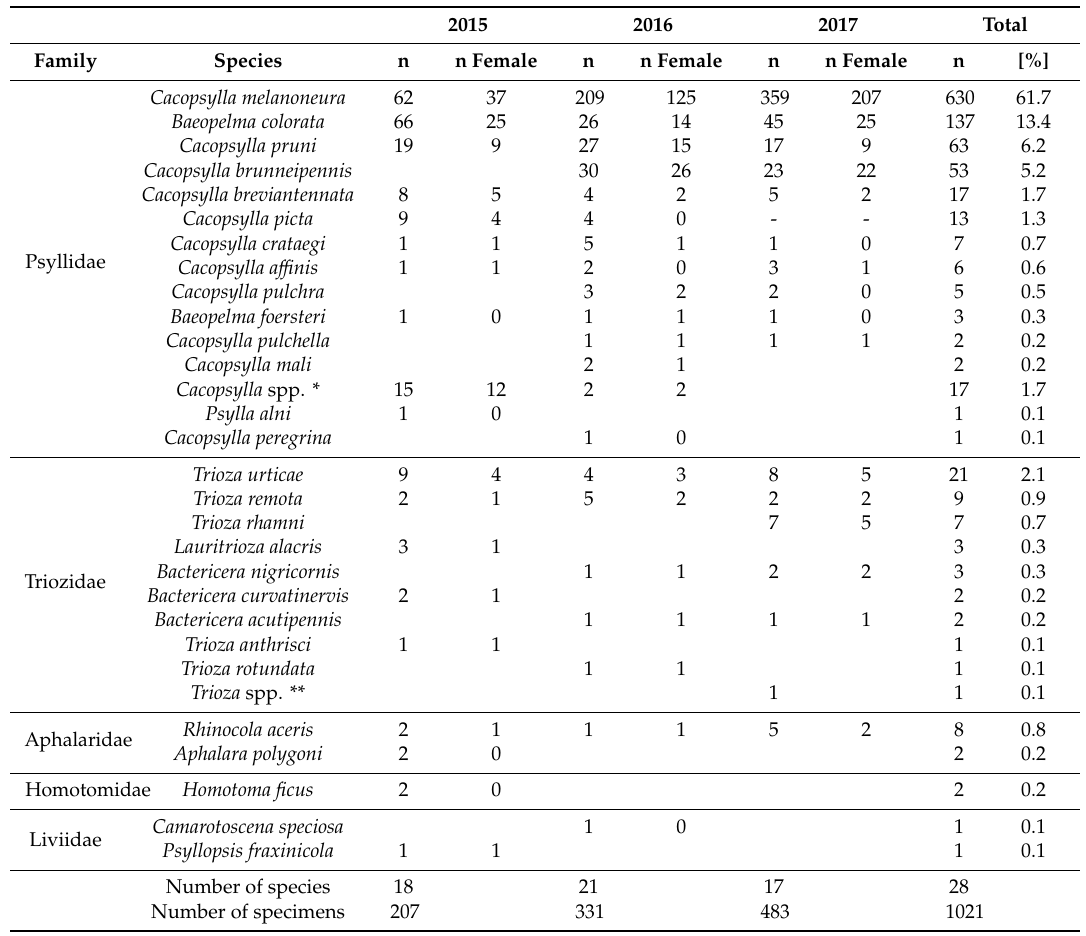
Table 1. A list of species of Psylloidea collected in the apple orchard near Merano, South Tyrol, Italy in 2015–2017; n = numbers of both sexes together, n female = numbers of females only. * indicates individuals that could not be unambiguously identified by morphological and molecular means; ** indicates individuals that could not be identified due to missing body